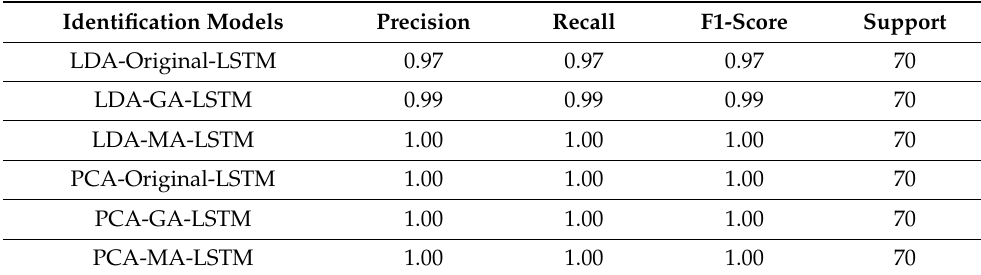
Table 1. Macro-average of different LSTM models.